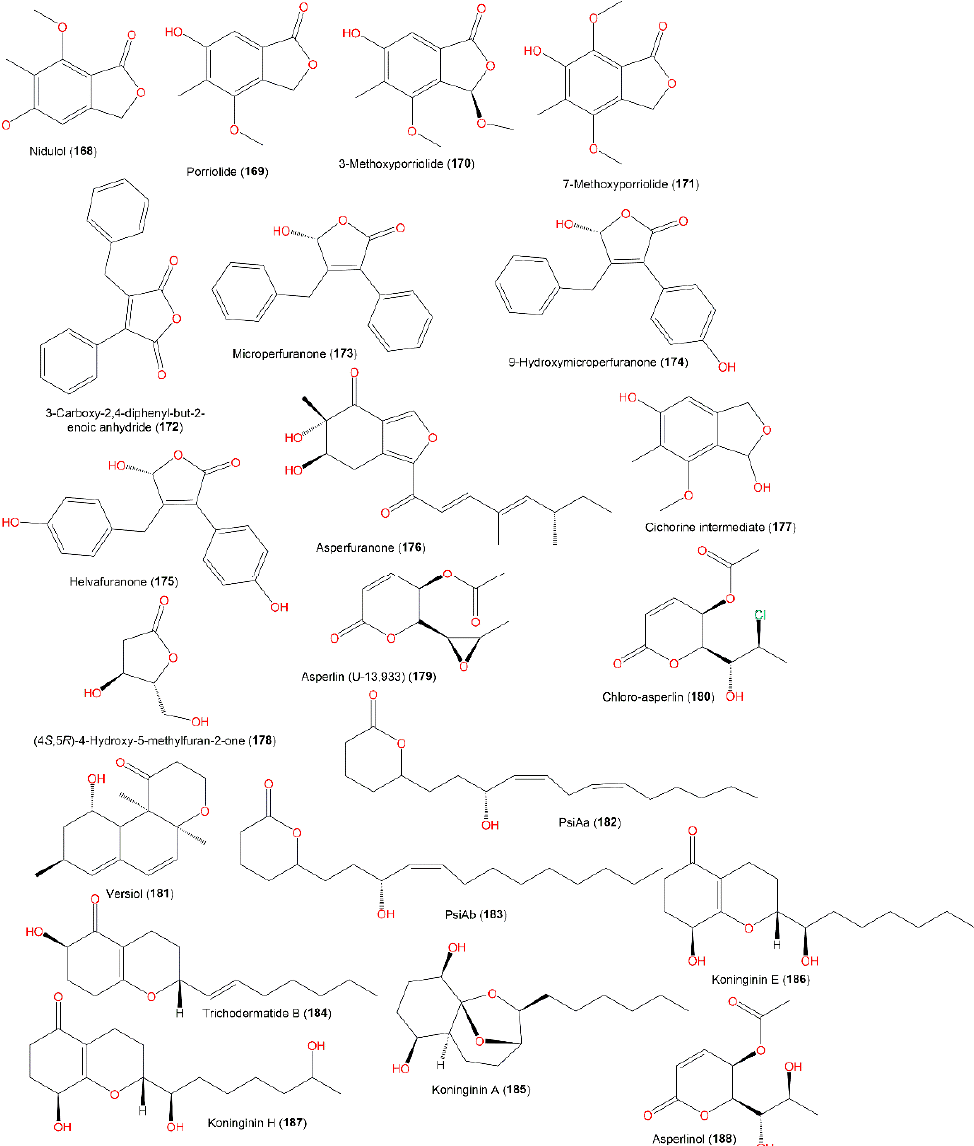
Figure 18. Structures of furan ( 168 – 178 ) and pyran ( 179 – 188 ) derivatives.